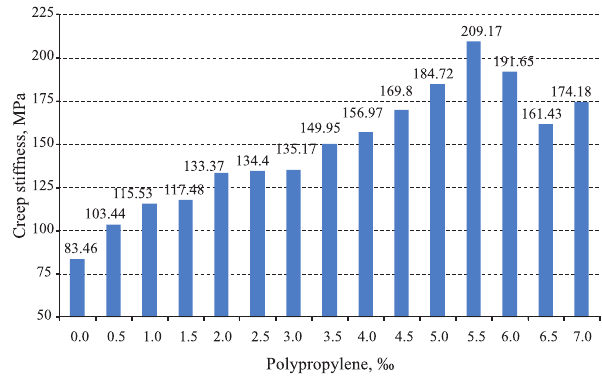
Fig. 4. Initial creep stiffness values for 15 sets of specimens at the end of static creep tests